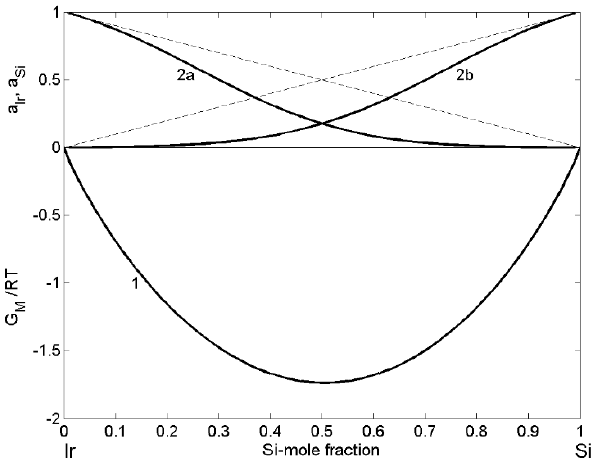
𝐺 (cid:3014) ; curve 1), the activities 𝑅𝑇(cid:3415) ; curve 1), the activ- RT